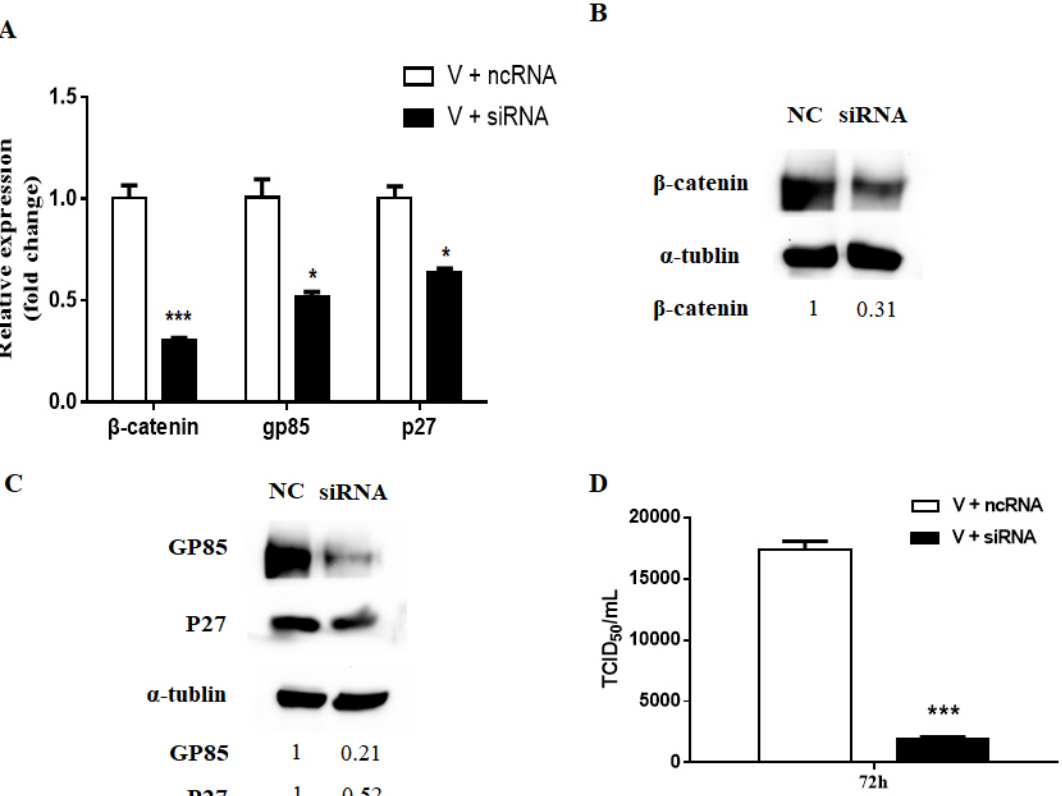
Figure 6. Knockdown β -catenin reduced ALV-J replication in CEF cells. The CEF cells were transfected with siRNA 986 targeting β -catenin (siRNA) or a control vector (ncRNA) for 24 h and then infected with ALV-J (MOI 1.0) for 72 h. ( A ) The gene expression levels of β -catenin, gp85, and p27 were tested with real-time PCR. The protein levels of β -catenin ( B ) and viral proteins, gp85 and p27, ( C ) were detected with Western blot. The control α -tubulin levels indicate that similar levels of protein were loaded into each lane, and the grayscale value of the bands in Western blot were analyzed with Image J software. ( D ) Virus titer were determined by TCID 50 assay. Differences in gene expression and virus titer assay between the groups were assessed with an analysis of variance followed by Student’s t -tests. Data were expressed as mean ±SD from three independent experiments and analyzed (* p < 0.05, *** p < 0.001). These experiments were performed independently at least three times with similar results.